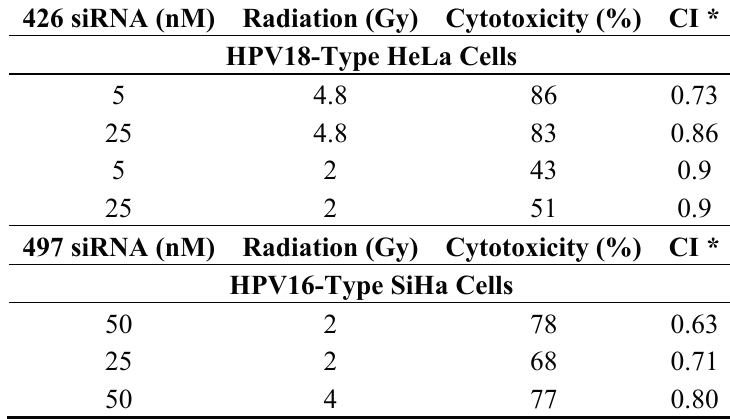
Table 1. The synergistic therapeutic effect of siRNA 426 or siRNA 497 in combination with γ -irradiation was demonstrated by Chou–Talalay